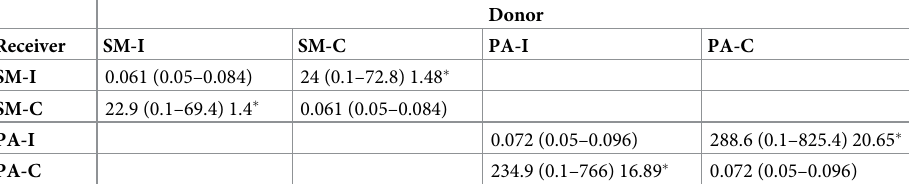
Table 2. Migration rate (M ij ) values per generation between populations.